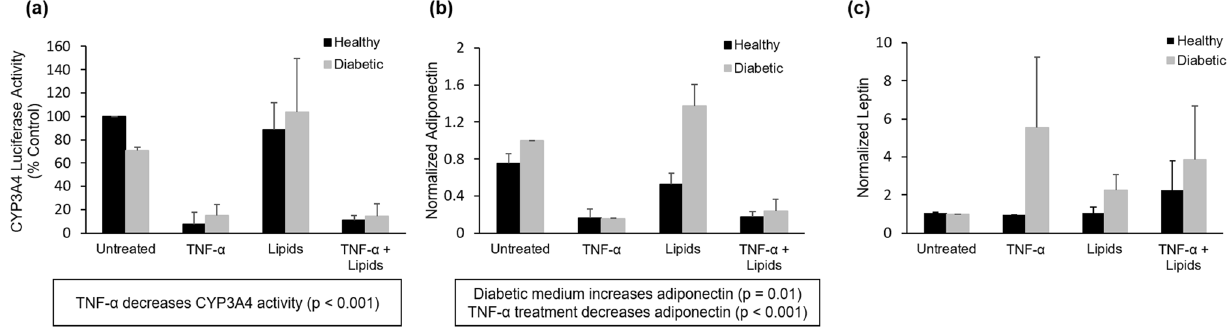
Figure 5. Cell function and biomolecule detection. ( a ) Viability-normalized hepatic CYP3A4 activity after 14d in recirculating systems. ( b ) Adipocyte adiponectin secretion ( c ) Adipocyte leptin secretion. Statistical analysis performed as multi-way ANOVA followed by Dunnett’s test (α = 0.05) using two independent coverslips per